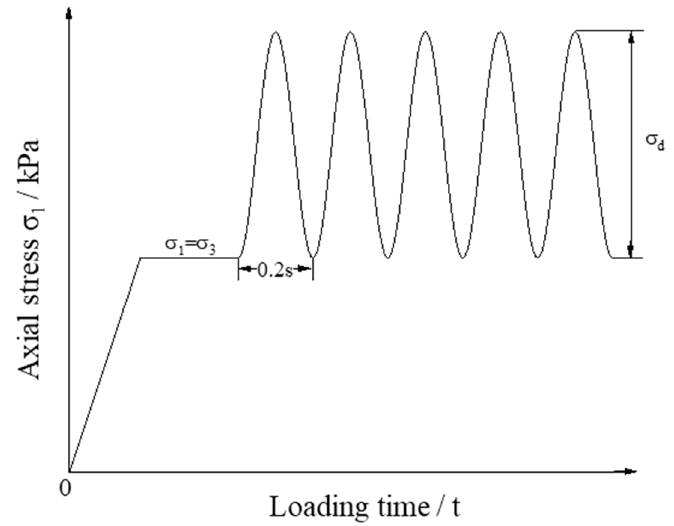
Figure 4. Illustration of the time–history curve of the axial load applied during laboratory repeated load triaxial compression tests.